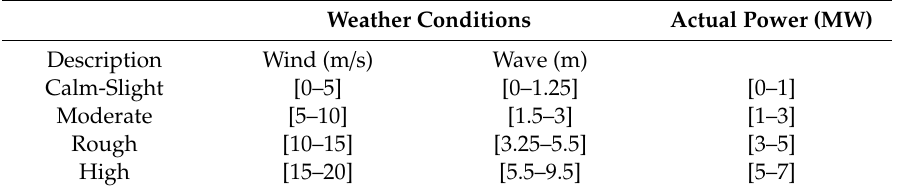
Table 2. Weather parameters data patterns based on the code of sea states (data from [36]).